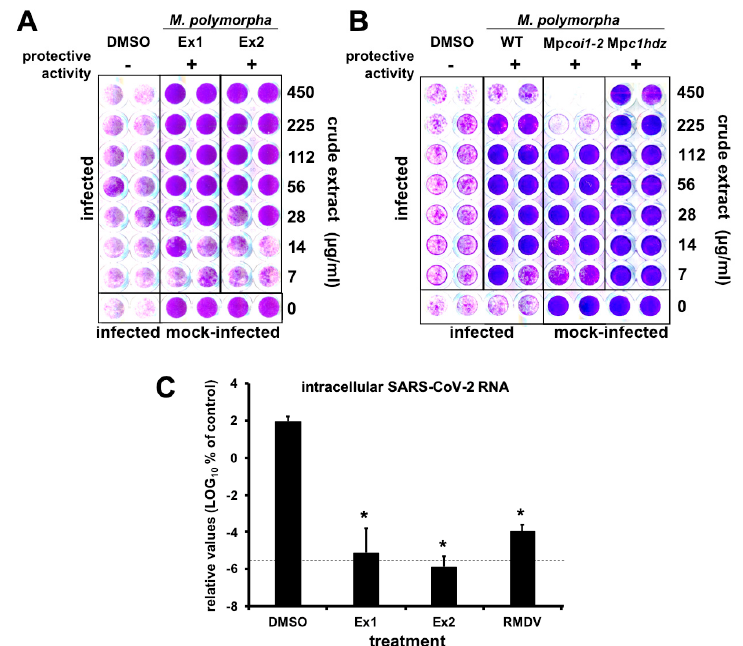
Figure 1. M. polymorpha extracts interfere with SARS-CoV-2-induced cytopathic effect and virus propagation. ( A , B ) Vero E6 cells were inoculated with SARS-CoV-2 (MOI = 0.001) in the presence of serial 2-fold dilutions of crude extracts from ( A ) two different M. polymorpha ecotypes, ruderalis (Ex1) and polymorpha (Ex2) or ( B ) WT, Mpcoi1-2 or Mpc1hdz Marchantia plants, incubated for 72 h, time after which they were fixed and stained with a crystal violet solution. Mock-infected cells were used as the control of the integrity of the cell monolayer. Images show a representative experimental plate comparing M. polymorpha extracts with vehicle (DMSO)-treated cells. ( C ) Vero E6 cells were inoculated with SARS-CoV-2 (MOI = 0.001) in the presence of vehicle (DMSO), RMDV (25 µ M) or a 100 µ g/mL dilution of crude extracts. Uninfected samples were used as the control (mock). Total RNA was extracted 72 h post-infection and subjected to RT-qPCR to determine viral load. The dotted line indicates the limit of detection of the assay. Normalized viral RNA levels are shown as percentage of the viral RNA found in vehicle-treated cells. Data are shown as mean ( ± SD) of three biological replicates. Statistical significance was estimated using one-way ANOVA and a Dunnet’s post hoc test (* p <